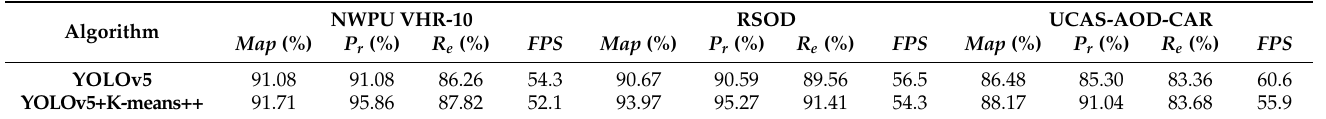
Table 1. Comparison of the detection performance of the improved algorithm embedded with K-means++ algorithm and the conventional algorithm.